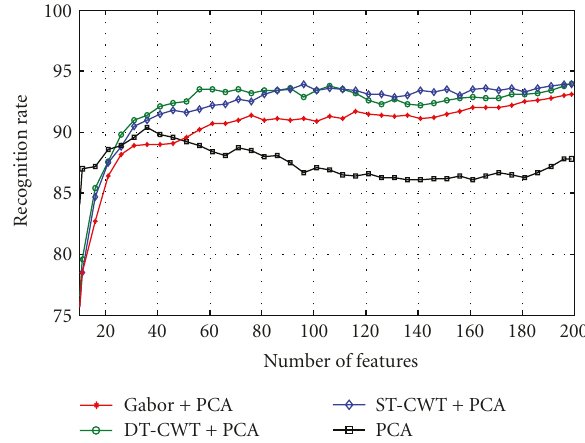
Figure 15: Face recognition performance of the ORL database using PCA, Gabor+PCA, DT-CWT+PCA, and ST-CWT+PCA for the δ L 1 ( L 1 ) similarity measure. The recognition rate means that the accuracy rate for the top response is correct.